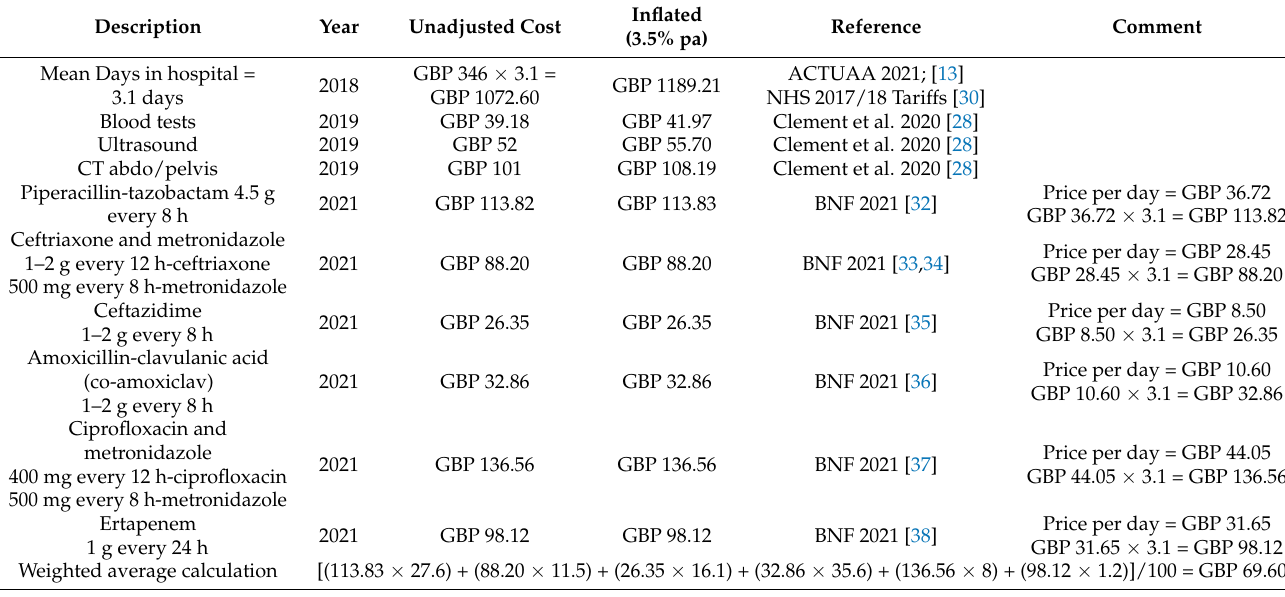
Table A3. Costs of Antibiotic therapy (the costs for mean days in hospital, blood tests, ultrasound, and CT were added to the weighted average of antibiotics to calculate the total).